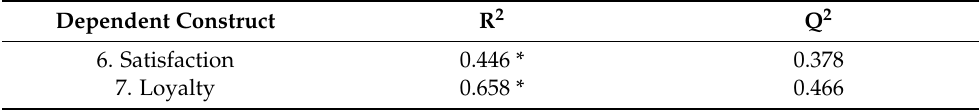
Table 6. Variance explained and cross-validated redundancy